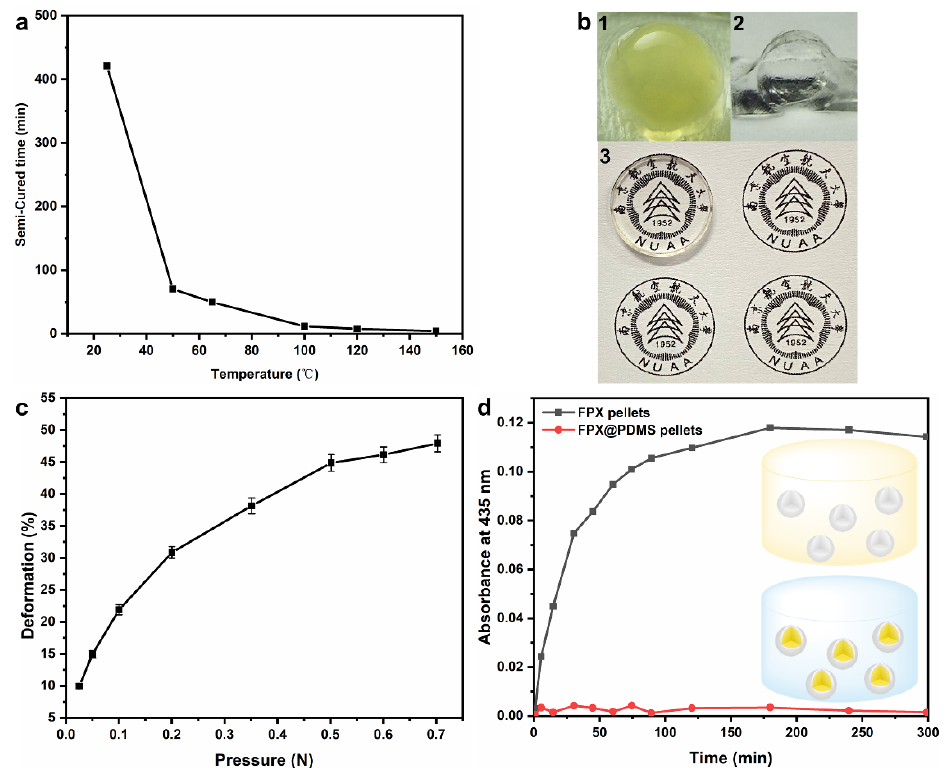
Figure 4. Optimization and characterization of the core-shell FPX@PDMS pellets. ( a ) Semi-cured time of PDMS at different temperatures. ( b )1 Optical photograph of the FPX@PDMS pellet; 2 Optical photograph of PDMS coating (inner FPX pellet has been removed); 3 Transparency of PDMS coating. ( c ) Deformation of the FPX@PDMS pellets as a function of